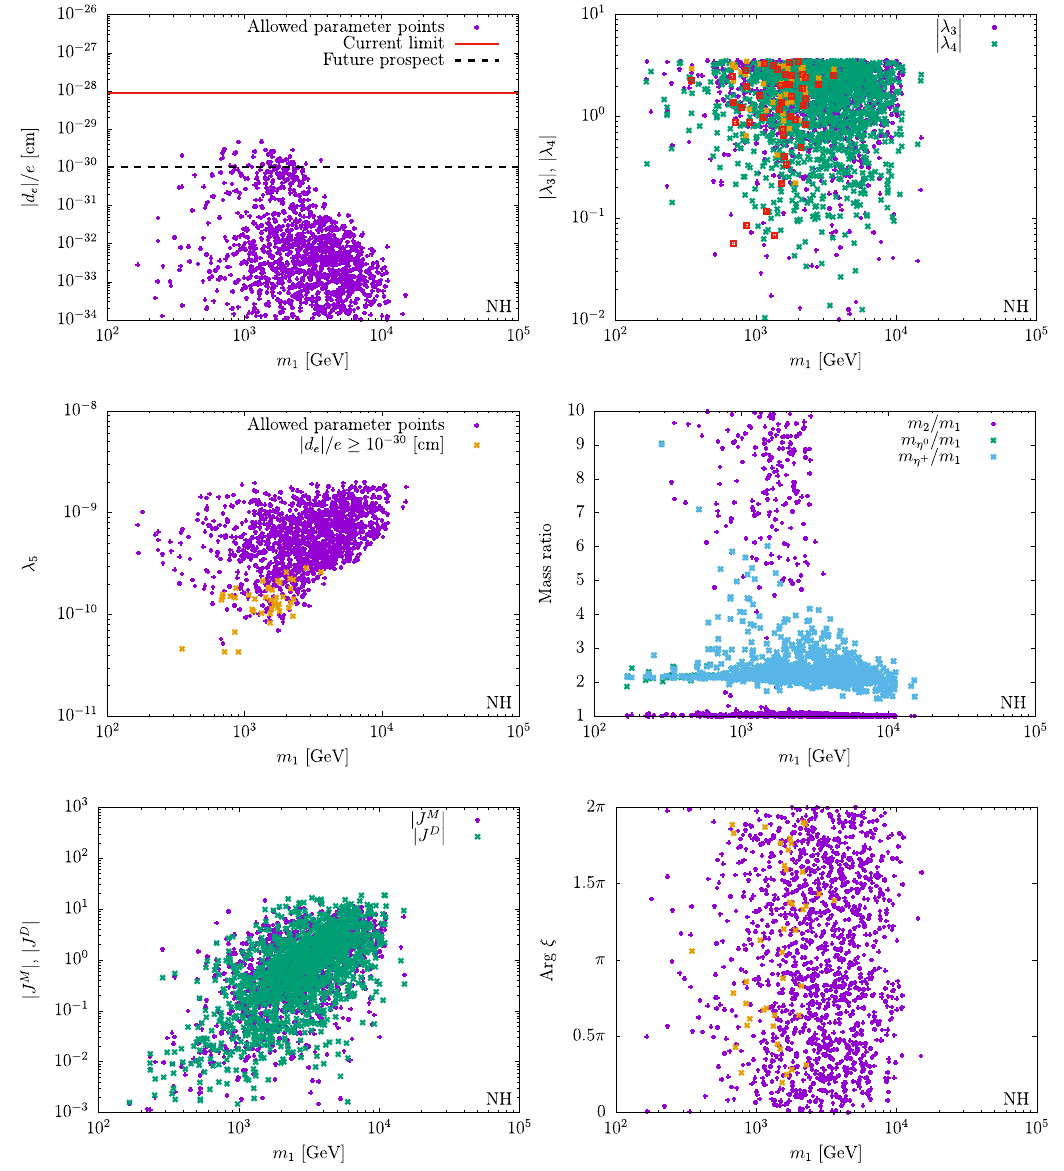
Figure 4 . Numerical results for fermionic dark matter in the case of normal hierarchy for the light neutrino spectrum. Each point complies with all the constraints discussed in section